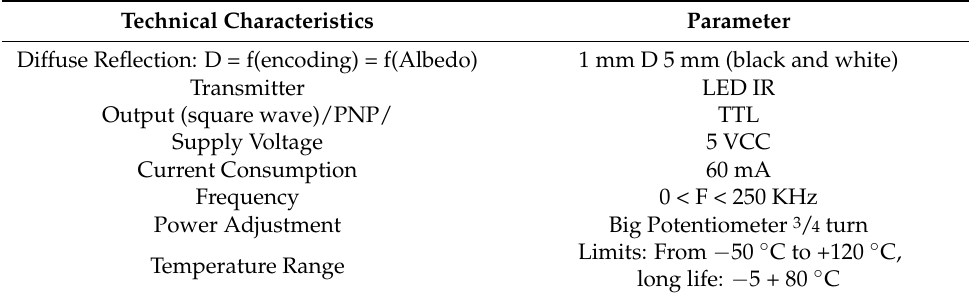
Table 3. Parameters of the laser sensor.